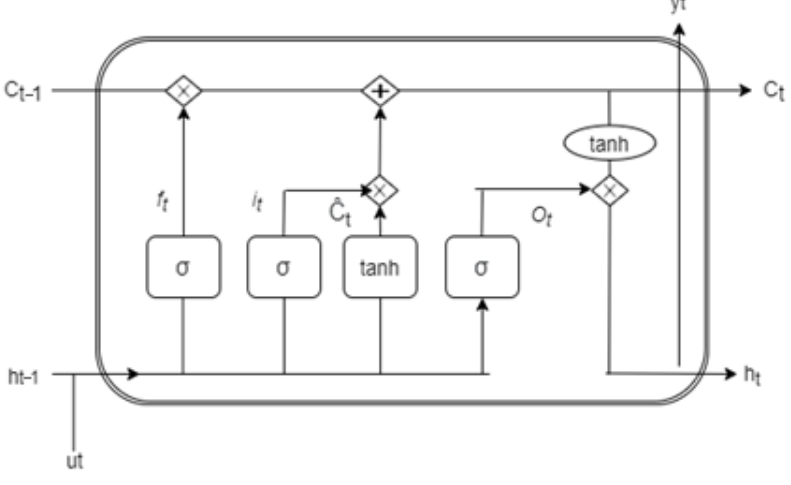
Figure 4. LSTM block at any